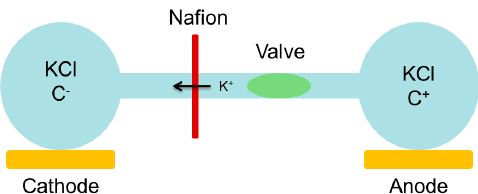
Figure 7. Role of the valve for the voltage potential. The open valve keeps constant voltage potential from the two chambers. The closed valve controls the amplitude of the voltage potential depending on the air-pressure used.